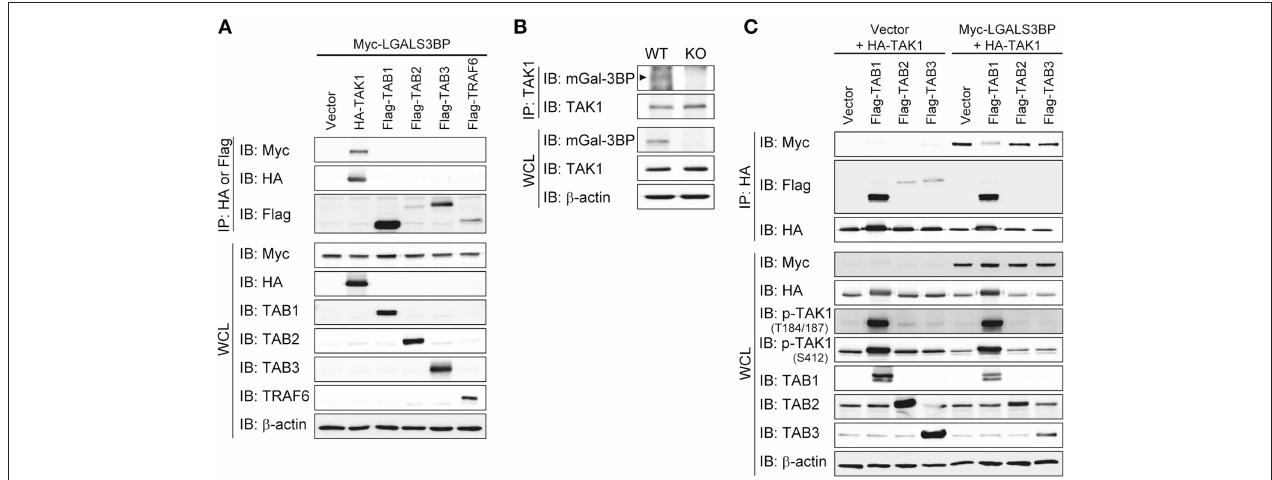
FIGURE 4 | Gal-3BP interacts with TAK1. (A,C) HEK293T cells were transfected with the indicated combination of expression plasmids. Immunoprecipitations were performed with HA or Flag antibodies. Interaction was detected by Western blotting with Myc- or Flag-tagged antibodies. The expression and activation levels of the transfected plasmids were confirmed by Western blotting of whole-cell lysate (WCL). (B) Immunoprecipitations were performed with TAK1 antibody to determine the interaction between endogenous TAK1 and mGal-3BP in WT and KO MEFs. Interaction and expression was detected by Western blotting with TAK1 and Gal-3BP antibodies.